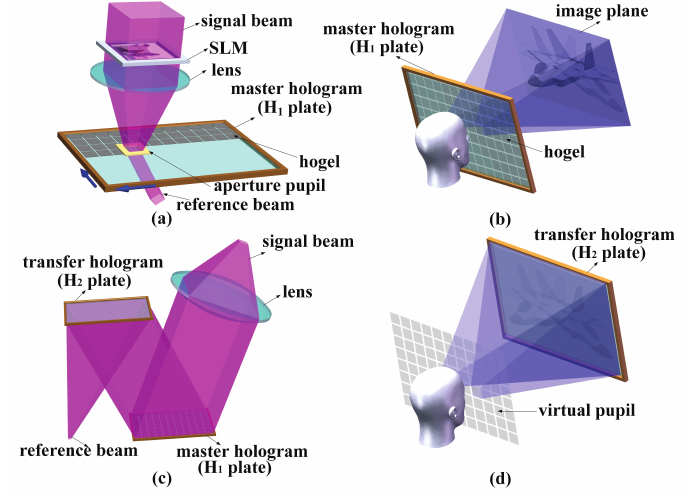
Figure 1. Production and reconstruction of the two-step method. ( a ) The production of the master hologram. ( b ) The reconstruction of the master hologram. ( c ) The reproduction of the master hologram to the transfer hologram. ( d ) The reconstruction of the transfer hologram. (Reprinted with permission from ref [29],